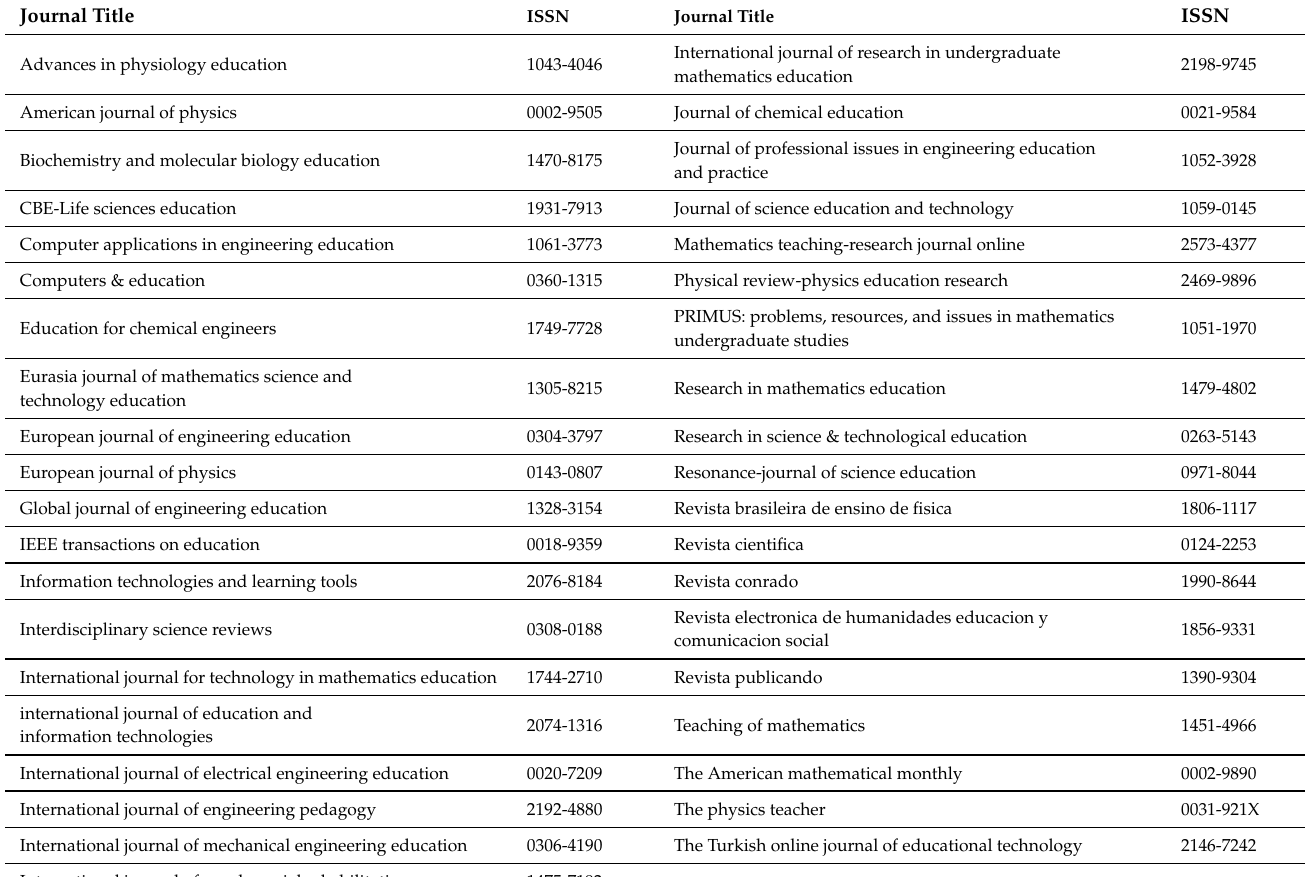
Table A2. List of journals associated to WOS and Scopus databases which appear when we search articles related with the teaching and learning of ordinary differential equations by applying the strings given in Appendix A and are not included in the list of Table